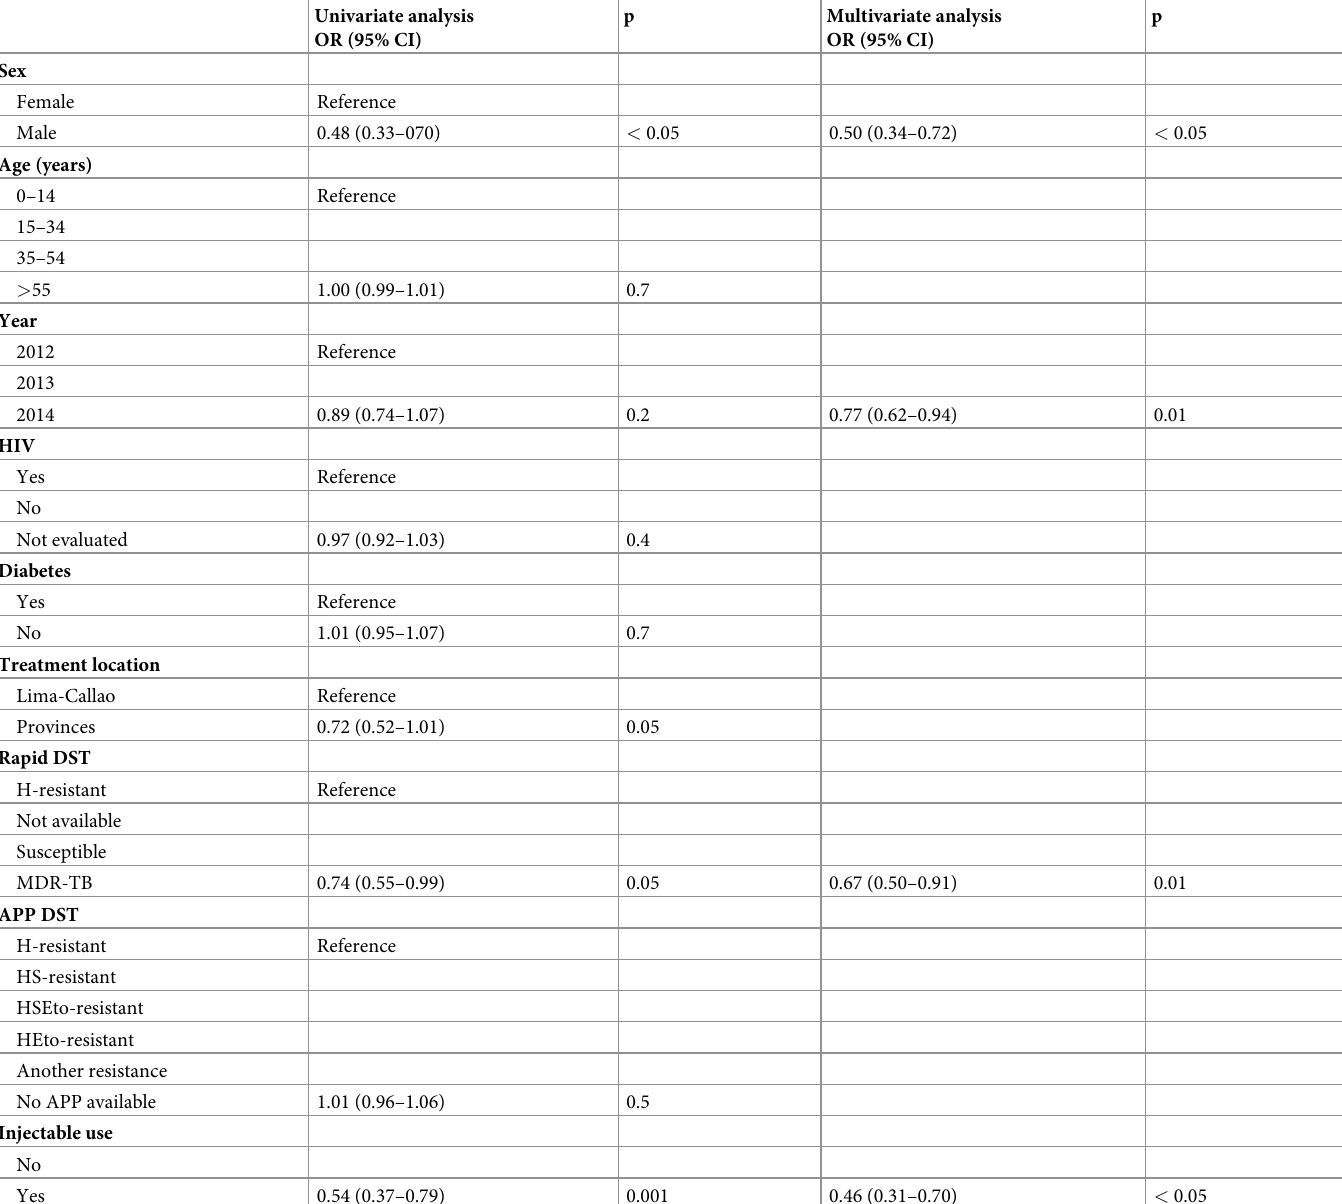
Table 3. Univariate and multivariate logistic regression analysis of variables that may affect treatment